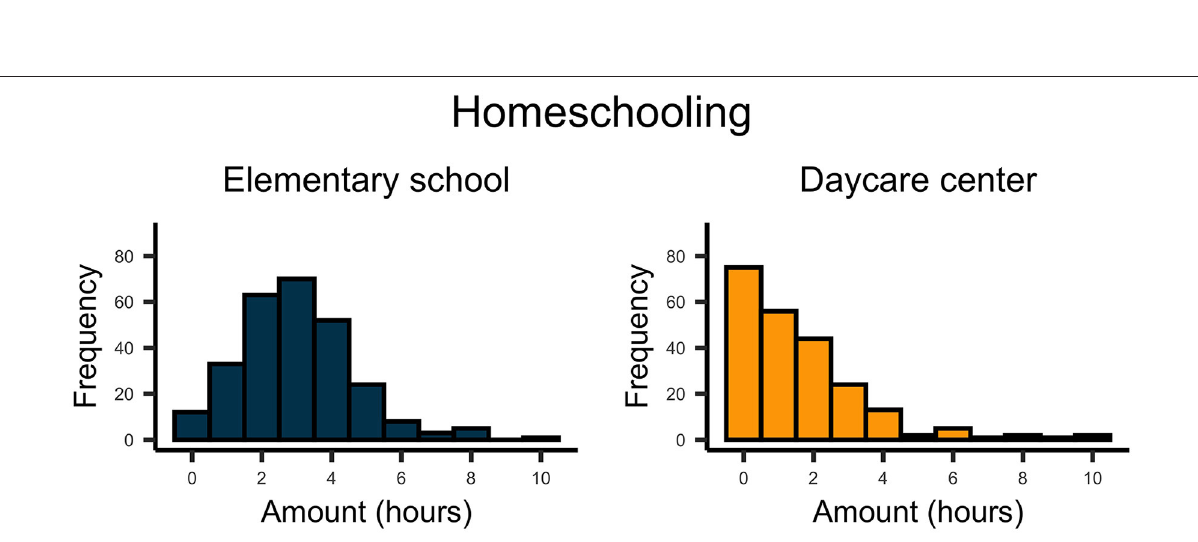
Frontiers in Psychology |